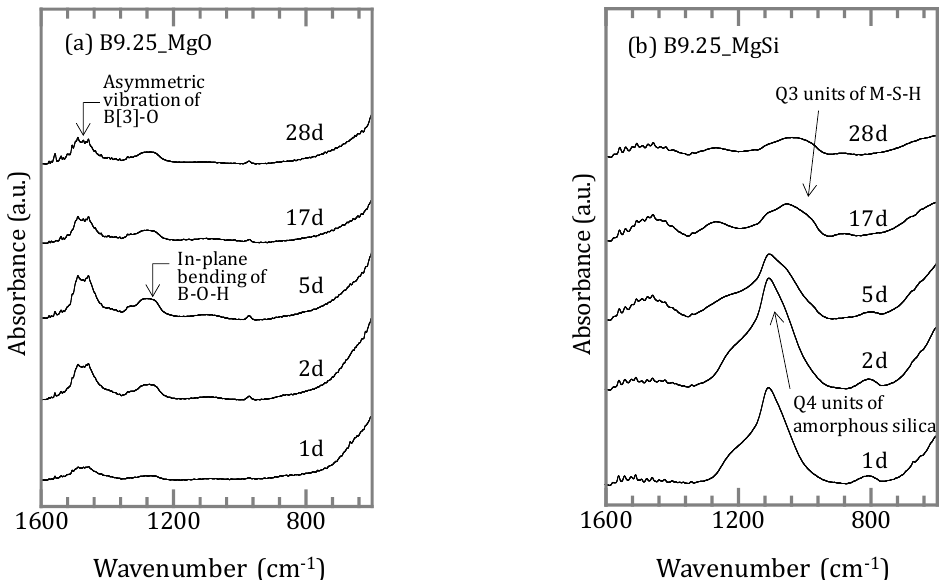
Figure 6. Fourier transform infrared spectrometer (FT-IR) spectra of samples ( a ) without amorphous silica and ( b ) with amorphous silica.